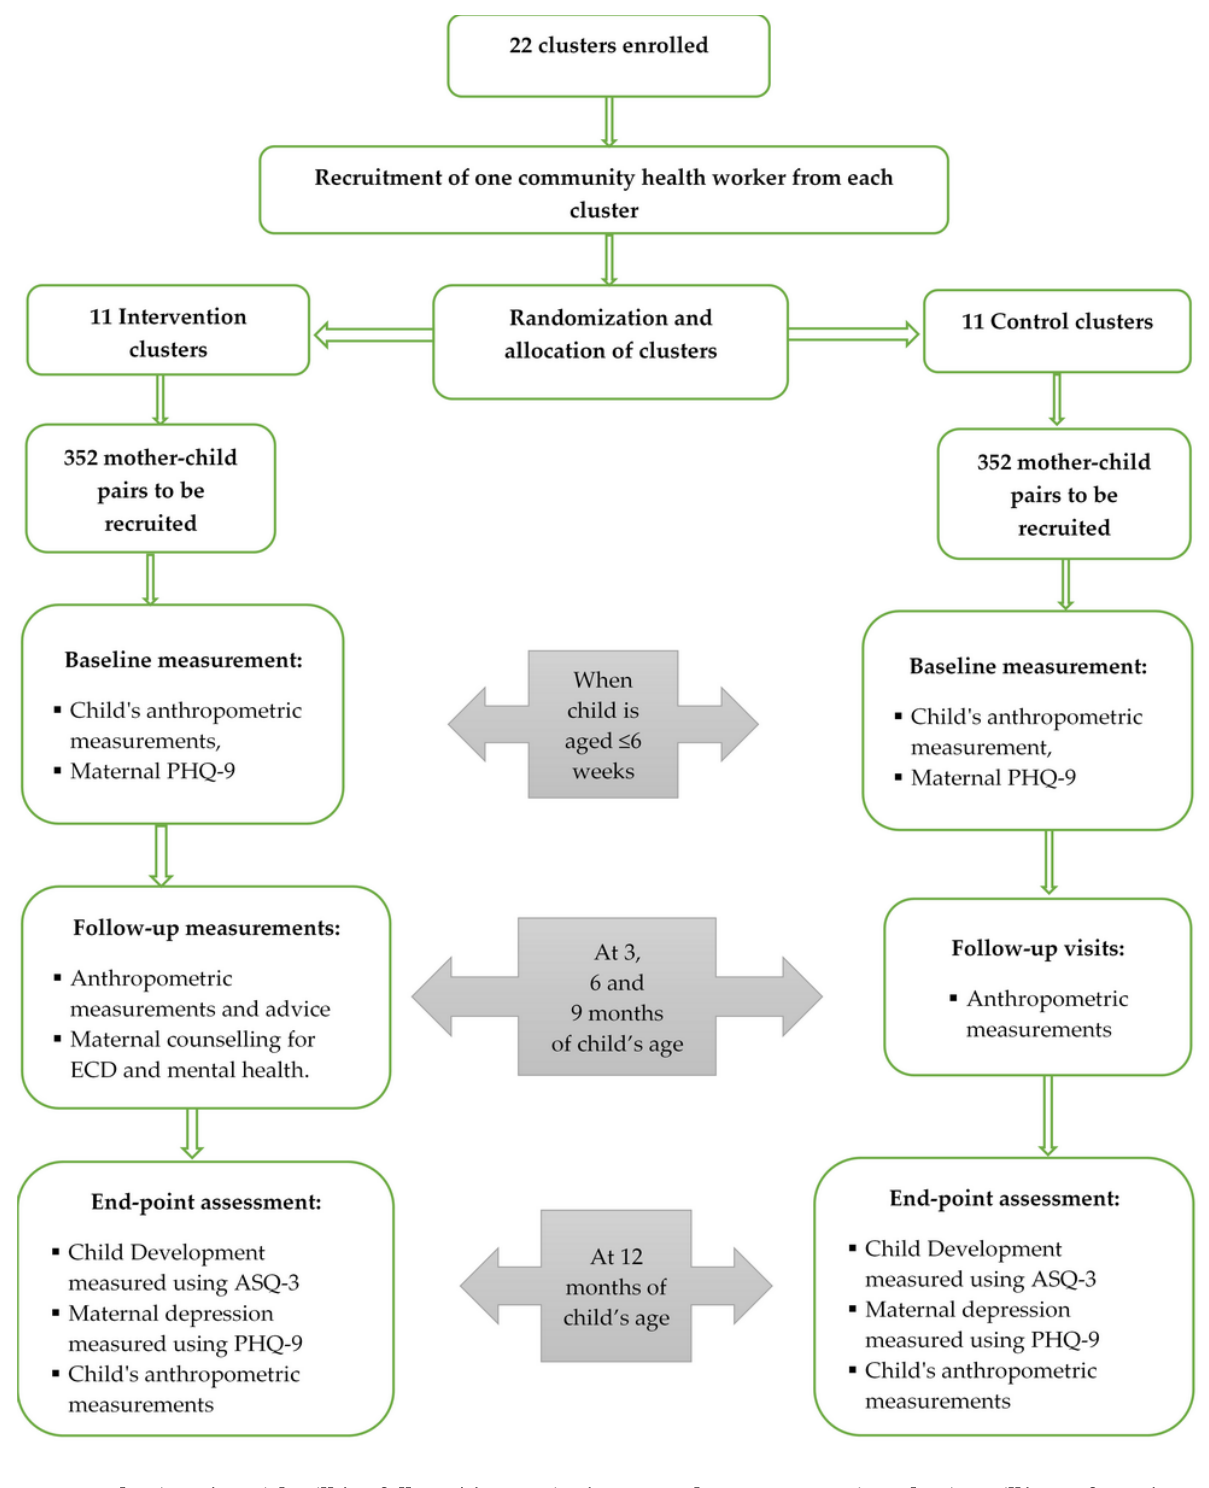
Figure 2. Trial flow. ECD: early childhood development; ASQ-3: Ages and Stages Questionnaire third edition; PHQ-9: Patient Health